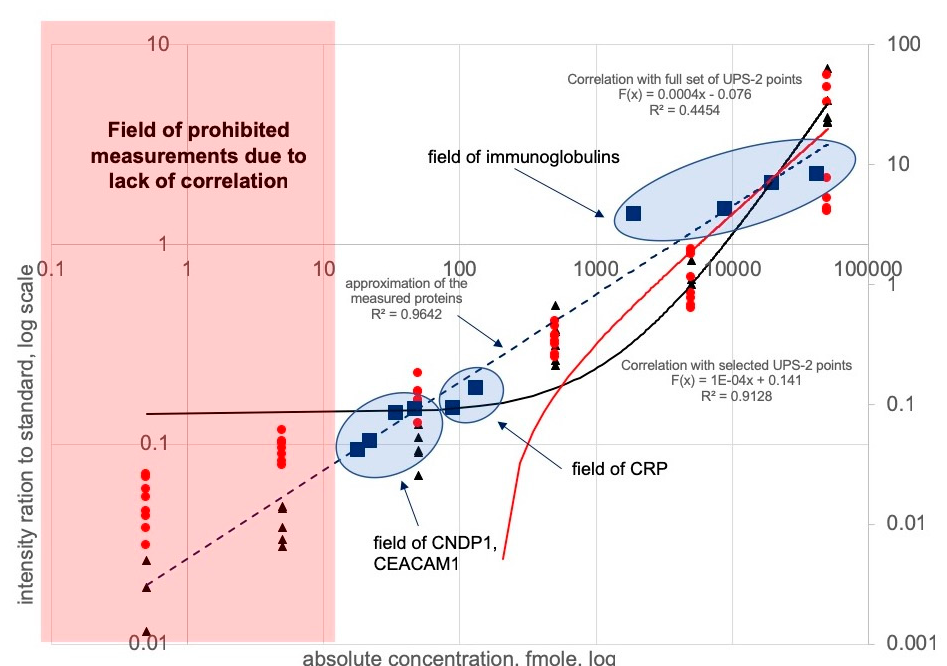
Figure 2. Calibration curve based on the measurements of the UPS-2 standards spiked into the non- human matrix. Red dots and red line indicate the complete set of calibration points plotted with correlation coefficient r 2 = 0.44. Rational selection of the appropriate calibration points (black points and black line) enhanced the calibration and altered the correlation coefficient to r 2 = 0.91. The prohibited margin for measurements was defined within 0.5–42 fmoles (red square) Proteins were measured within a range of 42–50,000 fmoles and plotted onto the selected correlation field indicated by blue circles. Approximation of the measured proteins CRP, CNDP1, CEACAM1 and immunoglobulins reached up to r 2 = 0.96.